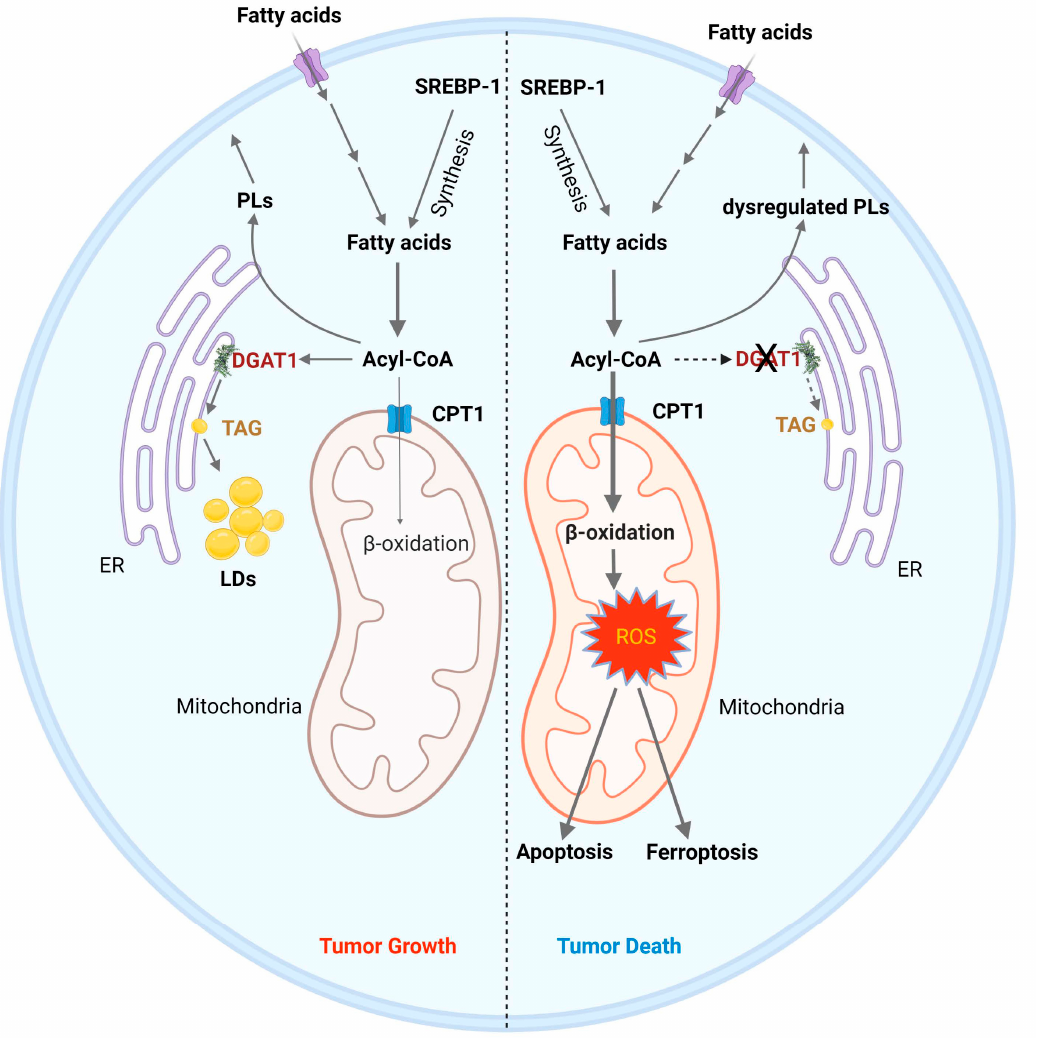
Figure 3. Inhibition of DGAT1 as a therapy strategy to induce cancer cell death. (1) Left : Tumor cells acquire fatty acids through uptake or de novo synthesis via the activation of SREBP-1. Fatty acids are converted to acyl-CoAs, which are the substrates for phospholipid (PL) synthesis and produce energy via entering into mitochondria to undergo β -oxidation and oxidative phosphorylation. Ex- cessive acyl-CoA is stored in LDs as catalyzed by DGAT1 in tumor cells. (2) Right : Inhibiting DGAT1 causes an imbalance of fatty acid catabolism, leading to cell death. Inhibiting DGAT1 forces more acyl-CoAs to enter the mitochondria through carnitine palmitate transferase 1 (CPT1) for β - oxidation, leading to high levels of reactive oxygen species (ROS), which trigger apoptosis and fer- roptosis to kill tumor cells. Moreover, the profile of PLs is altered upon DGAT1 inhibition, contrib- uting to further cellular stress. 6. Other Targets in LDs Gene expression analysis shows that hypoxia-inducible lipid droplet associated (HILPDA), one of the LD-associated proteins, is highly expressed in bladder, colon, kid- ney, lung, pancreas, and uterine cancers as well as in GBM [214]. HILPDA increases LD accumulation by inhibiting TG hydrolysis by the adipose triglyceride lipase (ATGL) and stimulating TG synthesis via DGAT1 [210,215]. Mao et al. reported that HILPDA overex- pression induced by hypoxia contributed to Bevacizumab resistance in GBM [216]. It may be a potential novel therapeutic target for GBM. Analysis of The Cancer Genome Atlas